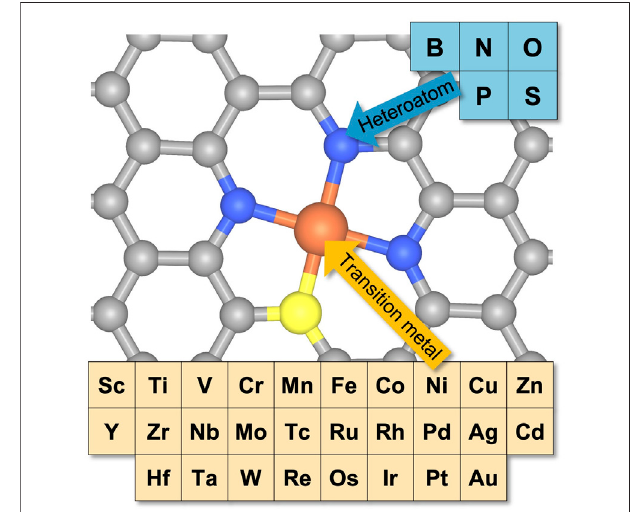
FIGURE 1 | A schematic illustration of the possible combinations of metal-heteroatom-doped carbon with 28 transition metals and fi ve heteroatoms when the coordinated heteroatoms are either the same or different at a ratio of 3:1. The gray, orange, blue, and yellow balls represent carbon, metal, host heteroatom, and dopant heteroatom,